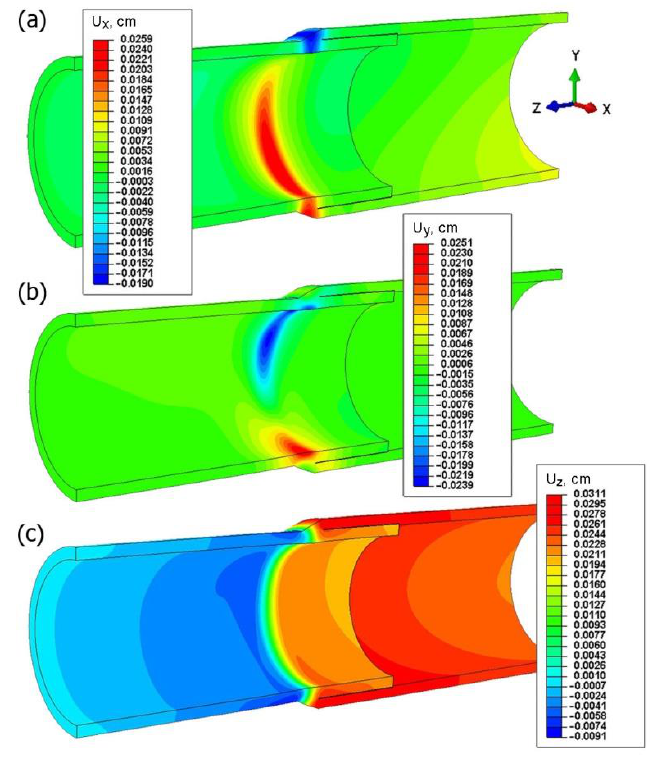
Figure 20. Displacement field in welded pipes.